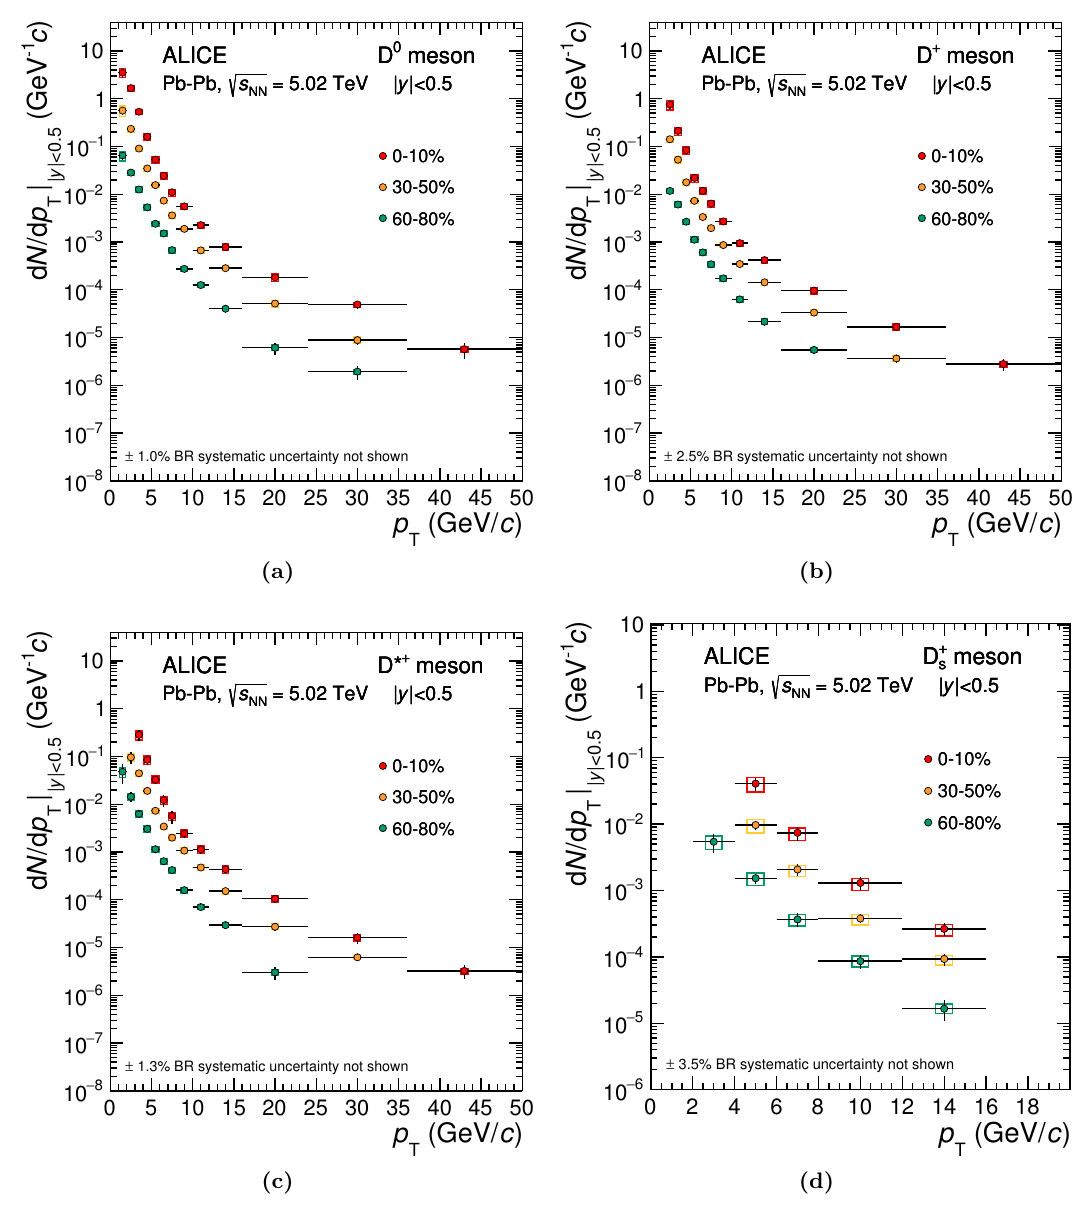
Figure 3 . Transverse momentum distributions d N= d p T of prompt D 0 (a), D + (b), D (cid:3) + (c) and D + (d) mesons in the 0{10%, 30{50% and 60{80% centrality classes in Pb{Pb collisions at s p s = 5 : 02 TeV. Statistical uncertainties (bars) and systematic uncertainties (boxes) are shown. NN The uncertainty on the branching ratios is quoted separately. Horizontal bars represent bin widths, symbols are placed at the centre of the